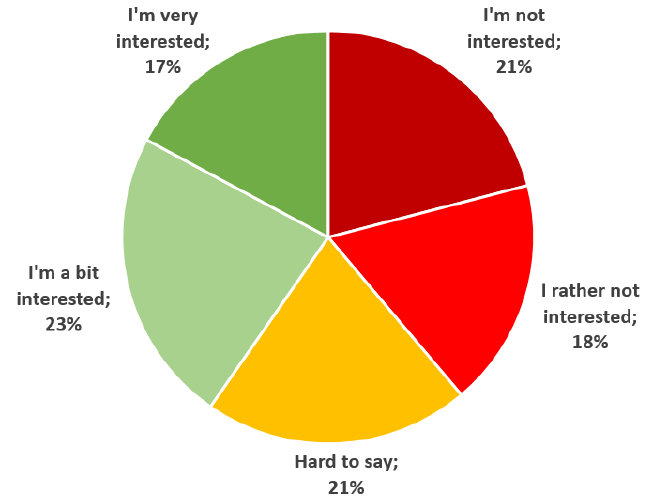
Figure 5. Interest in new technologies used in the automotive industry (N =